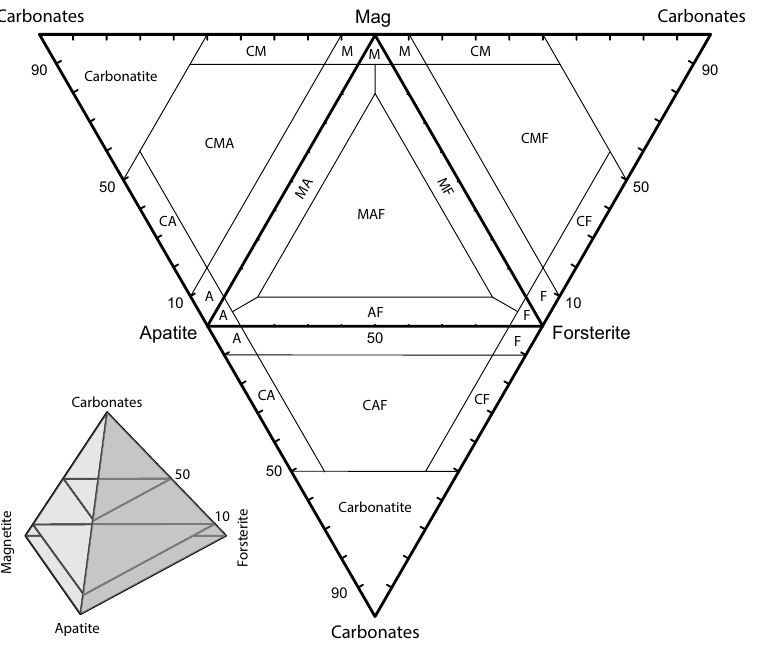
Figure 2. Classification scheme of the phoscorite-carbonatite series rocks. The classification tetrahedron (left bottom) and its net. Indexes in phoscorite names: A – apatite, F – forsterite, M – magnetite, and C – carbonates (calcite and dolomite) (modified ref. 14).